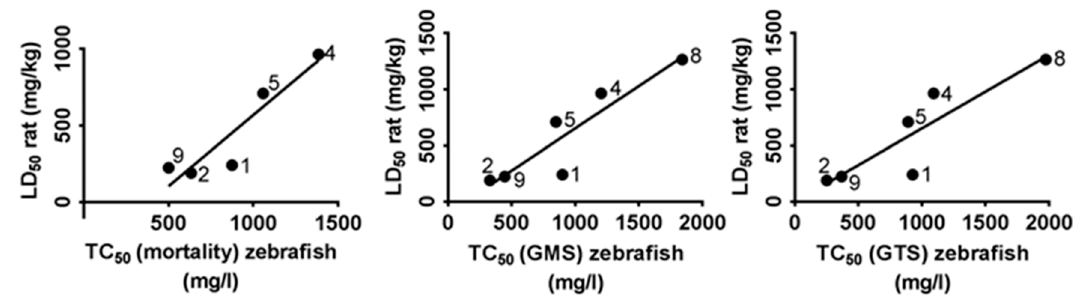
Figure 6. Correlation between TC 50 (Toxic Concentration, 50%) of zebrafish ( X -axis) and LD 50 (Lethal Dose, 50%) of rat ( Y -axis). The analysis included six of the nine tested methylxanthines: diprophylline was excluded because the value was too large and pentoxifylline because it was an outlier; no data were available about IBMX toxicity in rat. Numbers linked to each dot correspond to a methylxanthine compound, as reported in Table 2.